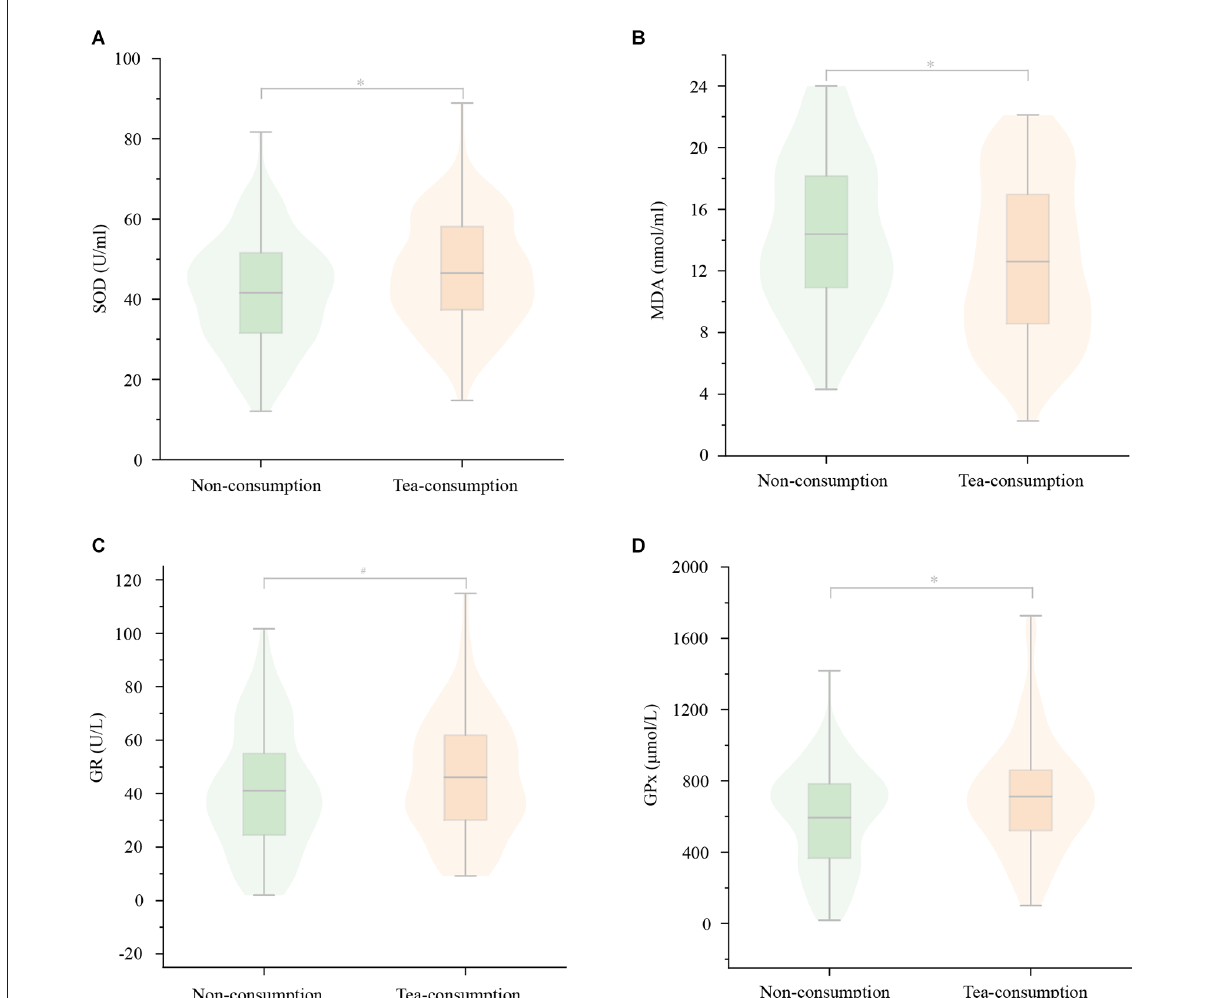
FIGURE6 The differences in serum oxidative stress markers between the non-consuming group and tea-consuming group. There were significant differences in serum SOD (A) , MDA (B) , and GPx (D) levels between the two groups, but no difference in serum GR (C) levels. The tea-consuming group had lower serum MDA levels and higher serum SOD and GPx levels. SOD, superoxide dismutase; MDA, Malondialdehyde; GPx, Glutathione peroxidase; GR, Glutathione reductase. ∗ P < 0.05; # P ≥ 0.05.